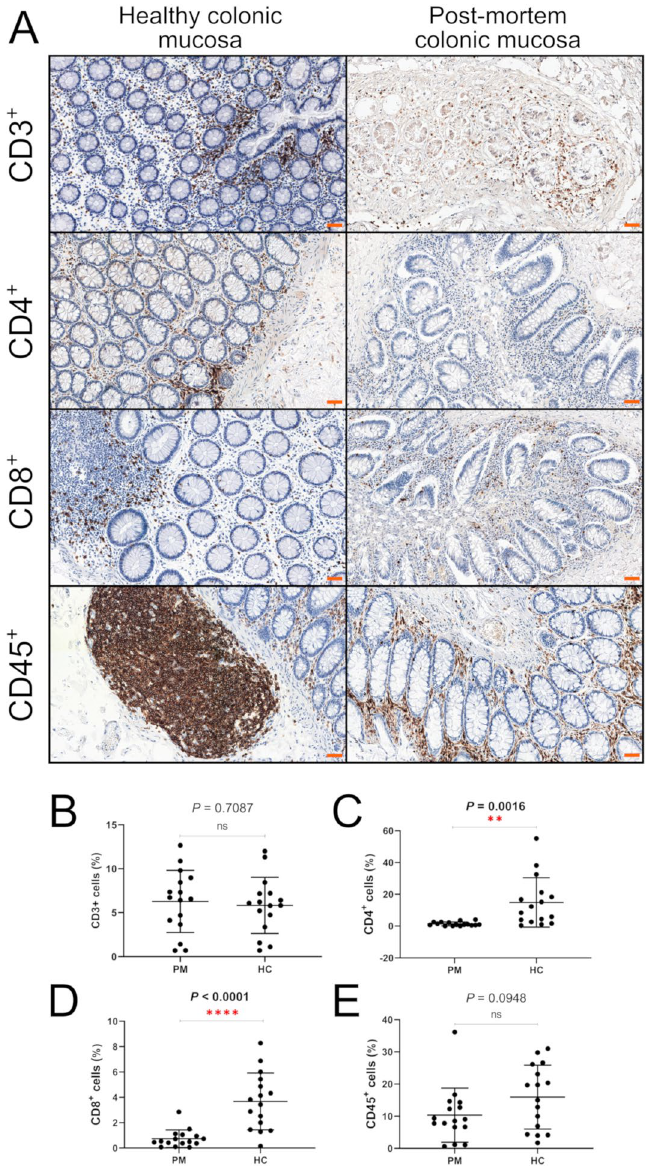
Figure 2. ( A ) Representative photos showing the distribution of CD3 + , CD4 + , CD8 + and CD45 + cells in normal and post-mortem intestinal mucosa. Particular attention should be drawn to clusters of lymphoid tissue, which seem to be the main source of immune cells infiltrating the lamina propria. Scale bars = 50 μm. ( B − E ) Comparison of immune cell numbers between normal colonic mucosa (HC; n = 16) and post-mortem samples (PM; n =